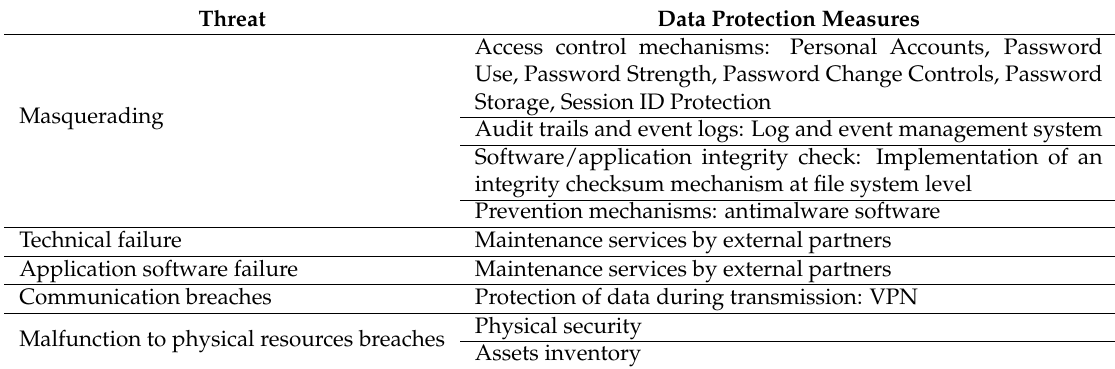
Table 7. Data protection measures for risk category: Data